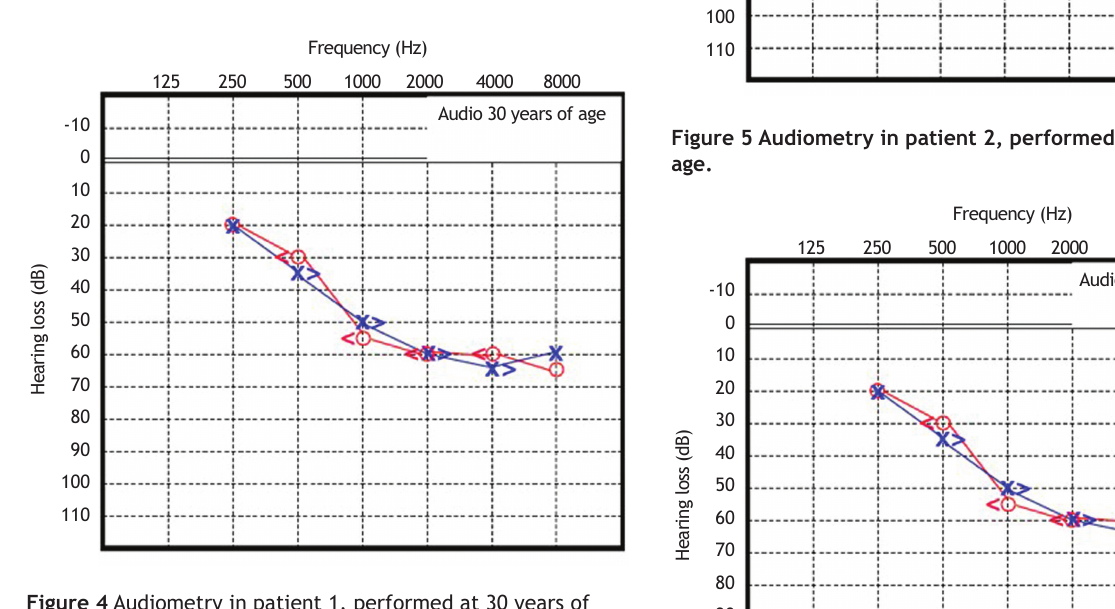
Figure 4 Audiometry in patient 1, performed at 30 years of age.